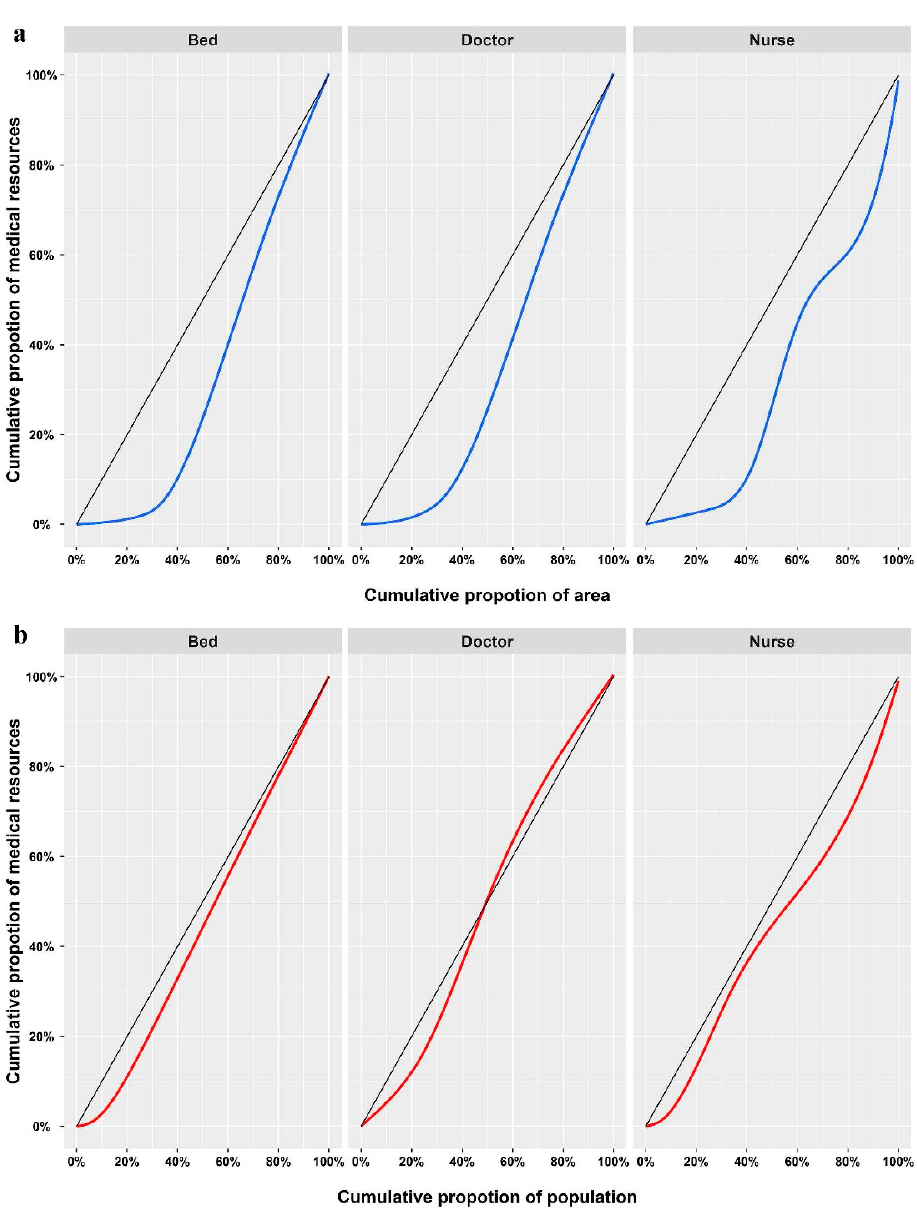
Figure 3. Lorenz curves for beds, doctors, and nurses based on ( a ) district area and ( b ) district